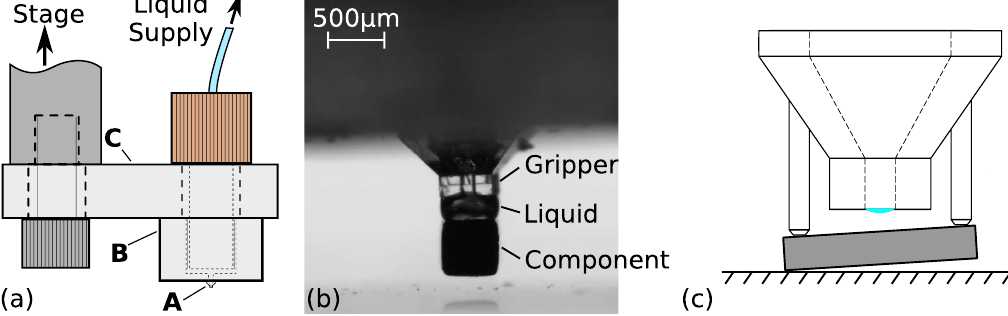
Figure 1. ( a ) Global overview of design ( b ) Example of capillary gripping [13] ( c ) Sketch of releasing mechanism based on unequal pillars design.